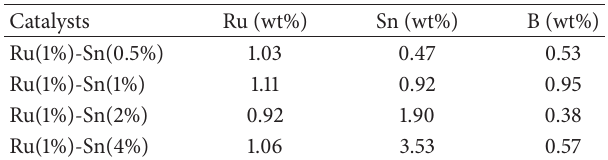
Table 1: Values of Ru, Sn, and B concentration as determined by ICP-OES.